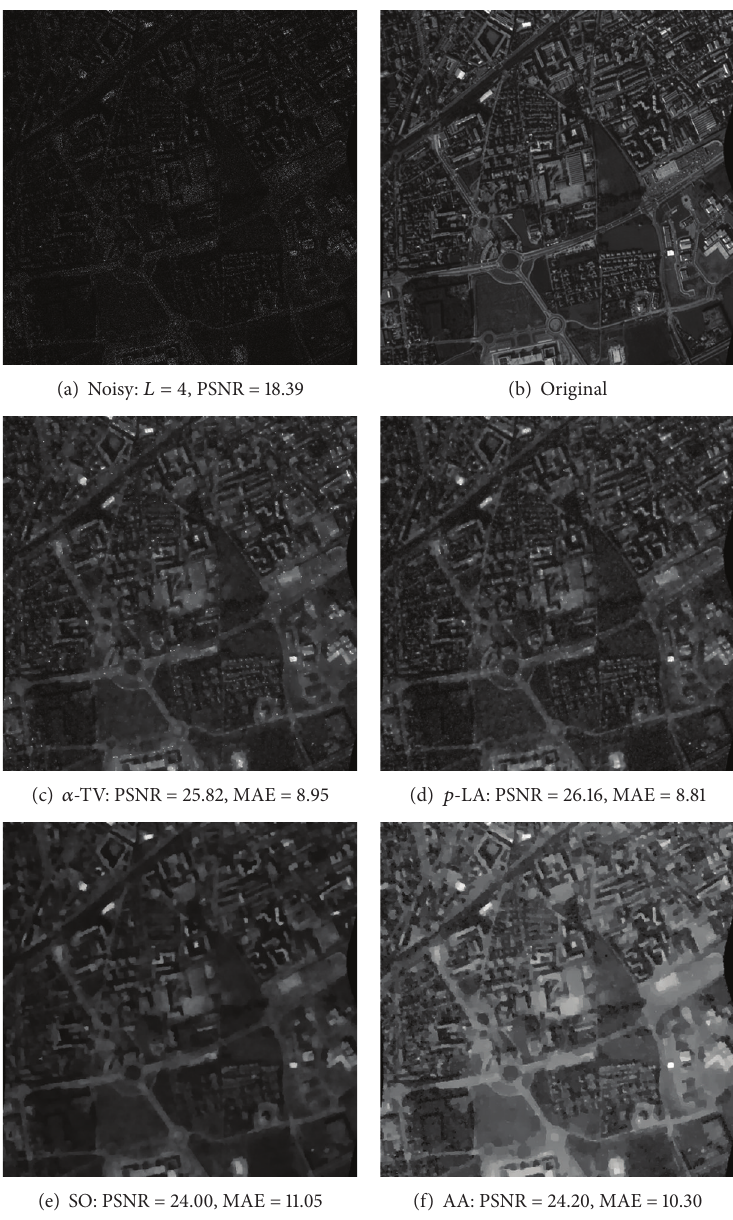
Figure 6: Aerial image ( 512 × 512 ). (a) Noisy image corrupted by speckle noise for 𝐿 = 4 in (8). (b) Original image. (c) Our algorithm by = 1.4 . (e) SO algorithm, 𝜆 = 0.3 , 𝛼 = 0.25 . (f) AA algorithm, 𝜆 = 120 . 𝛼 -TV, 𝜎 = 2 , 𝑘 = 0.015 , and 𝜏 = 0.05 . (d) Our algorithm by 𝑝 -LA, 𝑝 𝑈